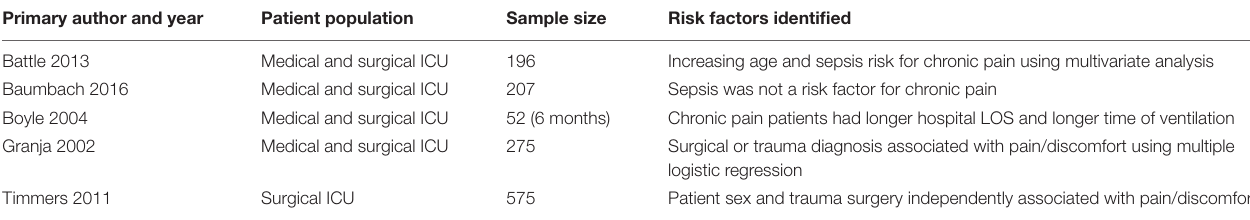
TABLE 2 | Risk factors for chronic post ICU